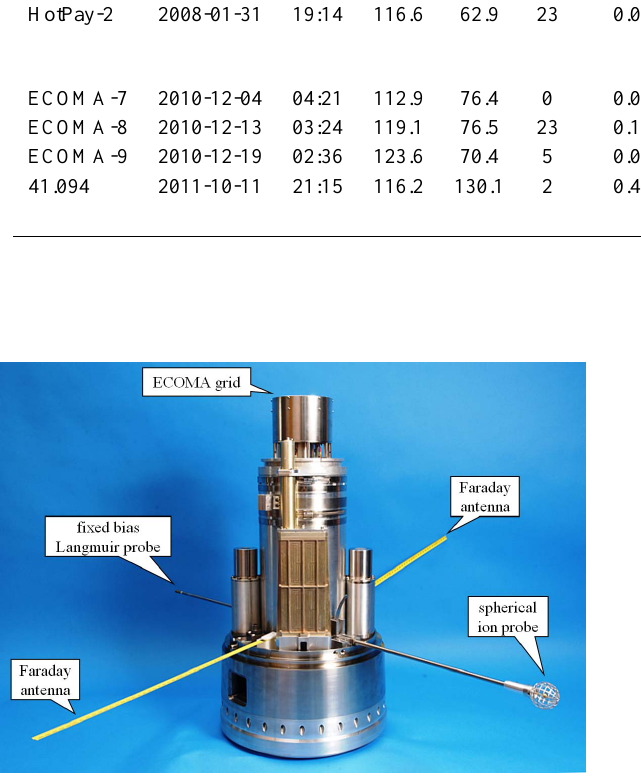
Figure 4 Forward section of an ECOMA payload in flight configuration. Fig. 4. Forward section of an ECOMA payload in flight configura-